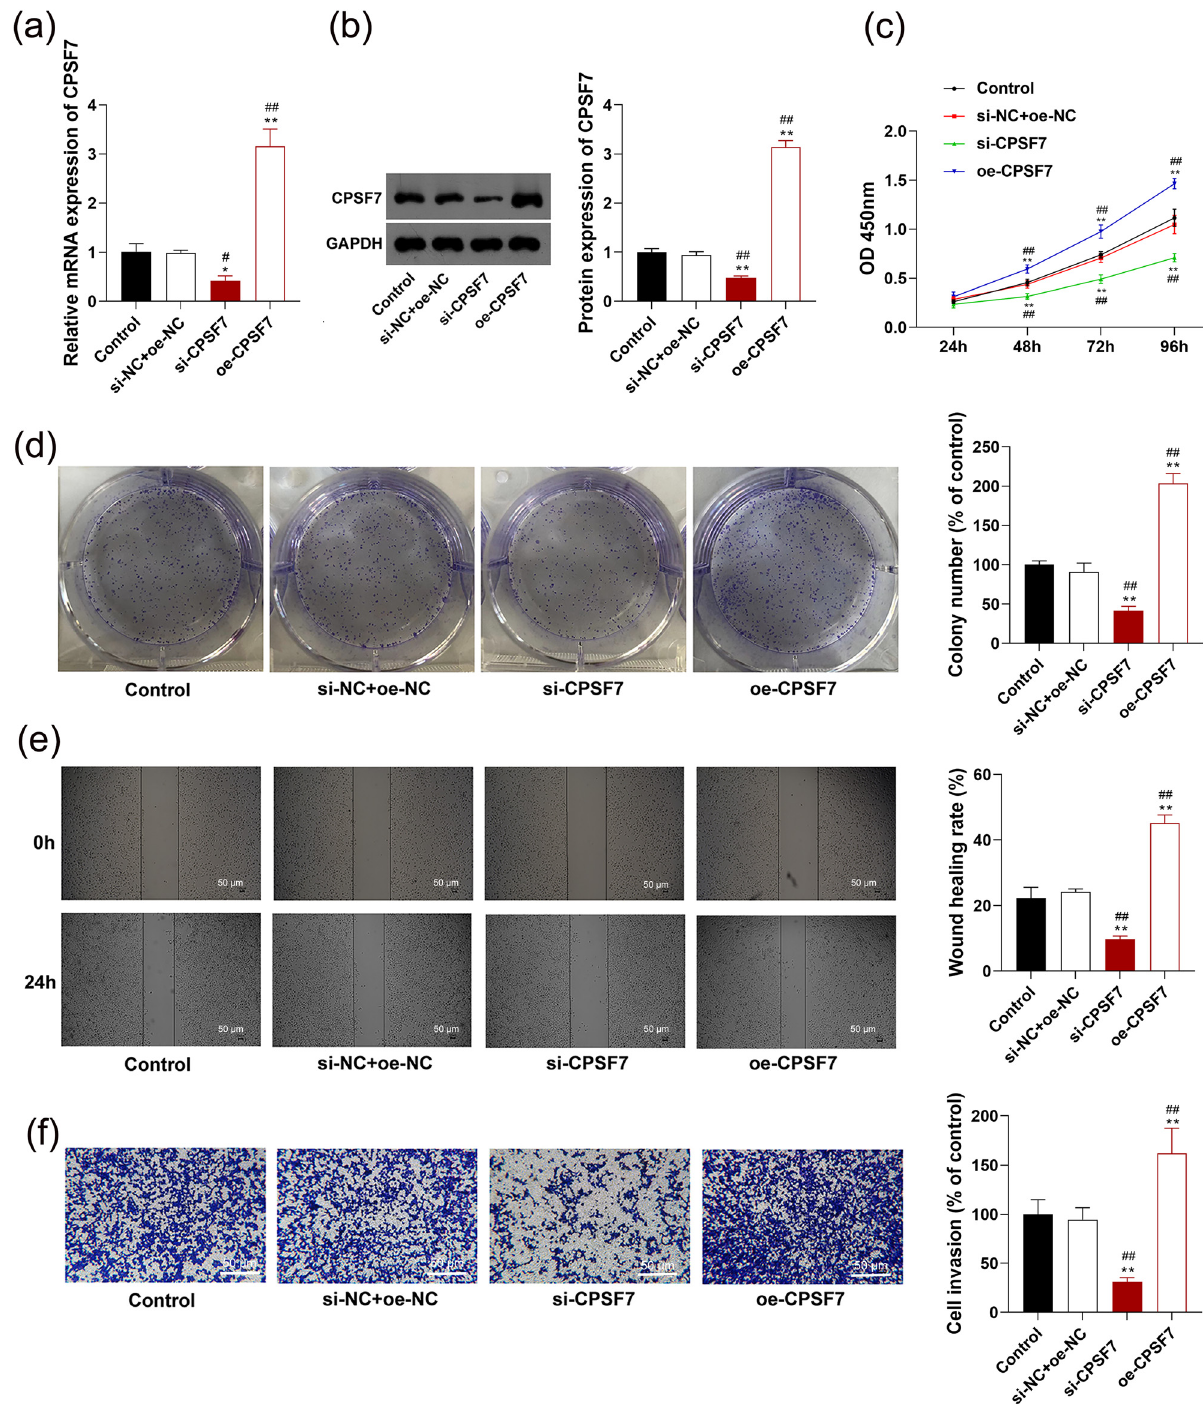
Figure 2: The role of CPSF7 in the malignant characteristics of LUAD cells: ( a ) mRNA expression of CPSF7 was measured using RT - qPCR. ( b ) Protein expression of CPSF7 was measured by Western blotting. ( c ) Cell viability was measured by cell counting kit ( CCK - 8 ) assay. ( d ) Colony number was detected by colony formation assay. ( e ) Cell migration rate was detected by wound healing assay ( scale bar = 50 µm ) . ( f ) Invasion rate was detected by Transwell assay ( scale bar = 50 µm ) . A549 cells were stably transfected with si - CPSF7 or oe - CPSF7 . Each experiment was repeated three times ( n = 3 ) . * P < 0.05, ** P < 0.01 vs Control; # P < 0.05, ## P < 0.01 vs si - NC + oe -